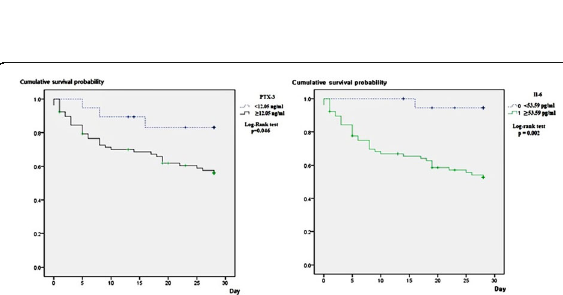
Fig. 3 (abstract P14). Kaplan-Meier Curve of 28-day Mortality in Patients with Sepsis and Septic Shock Stratified by the Optimal Cut- off Value of Pentraxin-3 (a) and Interleukin-6 (b) for Predicting Septic shock (28-day mortality by pentraxin-3: 16.9% vs 43.9%, 28-day mortality by interleukin-6: 5.6% vs 47.4%)